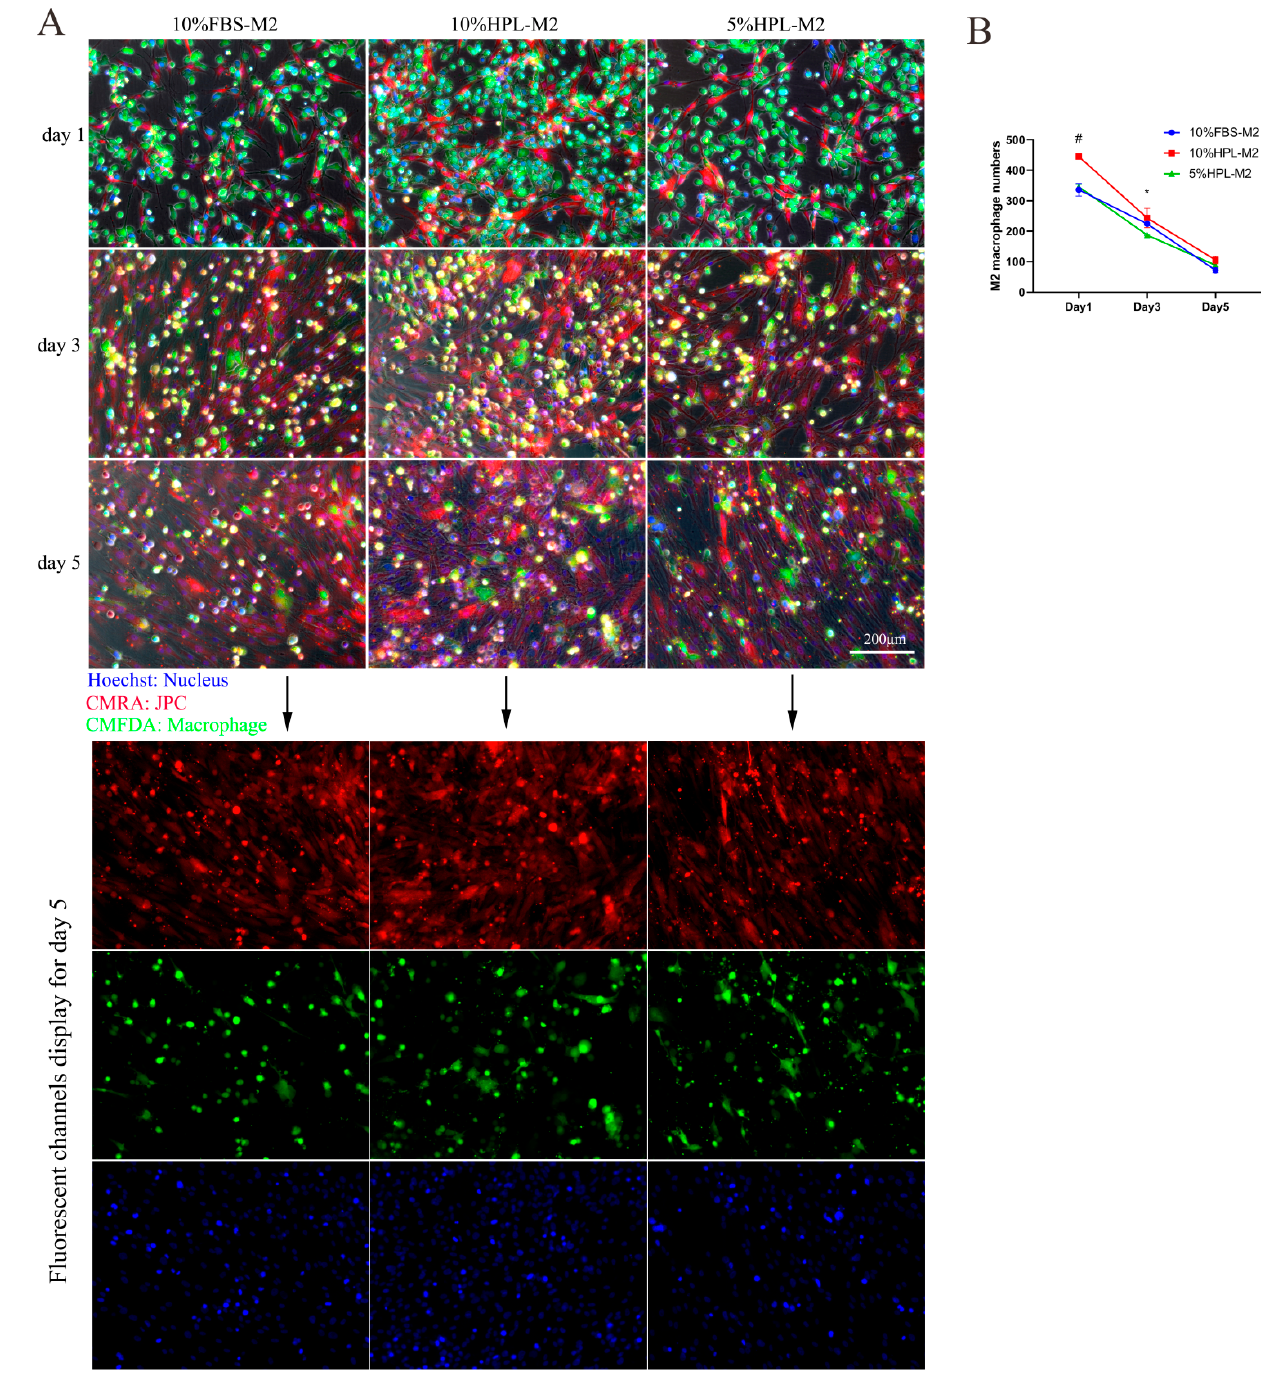
Figure 8. Cell tracking of JPCs and M2 macrophages cultured under 10% FBS, 10% hPL, or 5% hPL supplementation by fluorescence microscopic images. ( A ) Representative fluorescence micrographs of JPCs and M2 macrophages on the first, third, and fifth days of coculture (blue: nucleus; red: JPC; green: macrophage); scale bar: 200 μ m. ( B ) M2 macrophage numbers counted in the fluorescence images at days 1, 3, and 5 of coculture with JPCs ( n = 3, 5% hPL compared with 10% FBS * p < 0.05, 5% hPL compared with 10% hPL # p < 0.05).